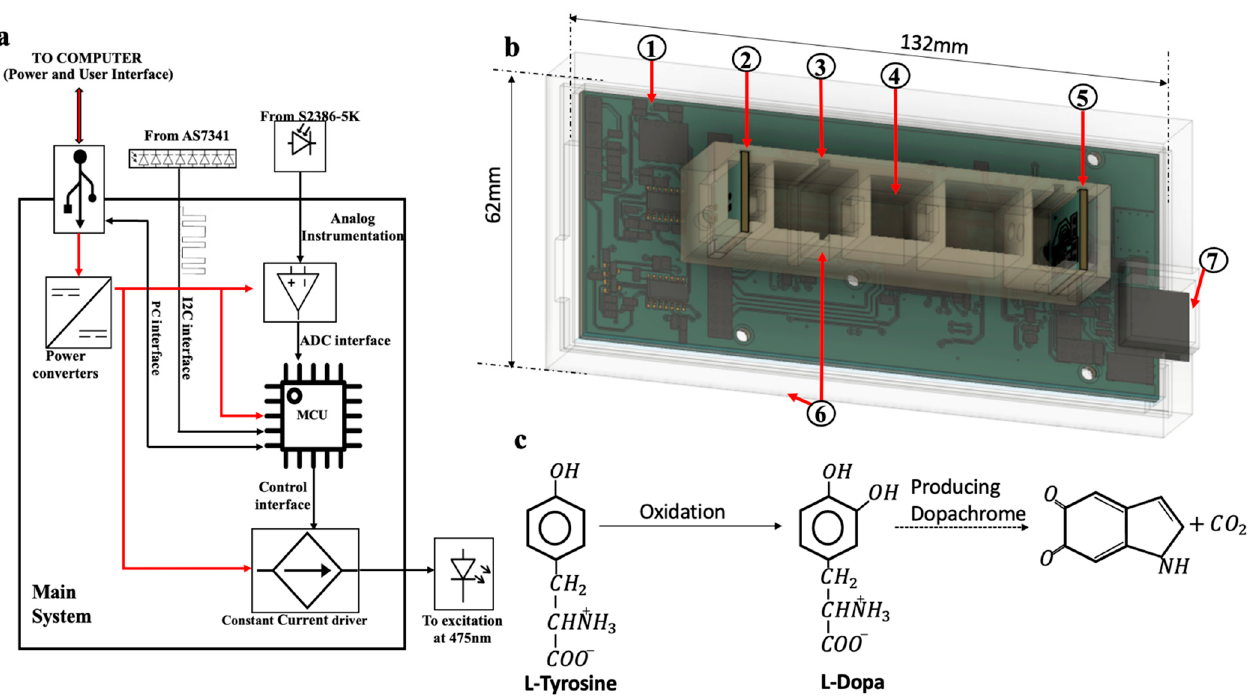
Figure 1. The overall system monitoring enzyme kinetics and the reaction theory is shown. ( a ) The overall system block diagram is shown along with its respective interfaces. ( b ) The 3D design isometric view of the spectrophotometer is shown with the packaging profile indicating different major subsections. The representations are as follows: (1) master PCB, (2) excitation source, (3) slot for optical filter, (4) measurement cavity to place the sample, (5) detector daughter PCB, (6) outer enclosure, (7) USB interface. ( c ) The chemical reaction of the